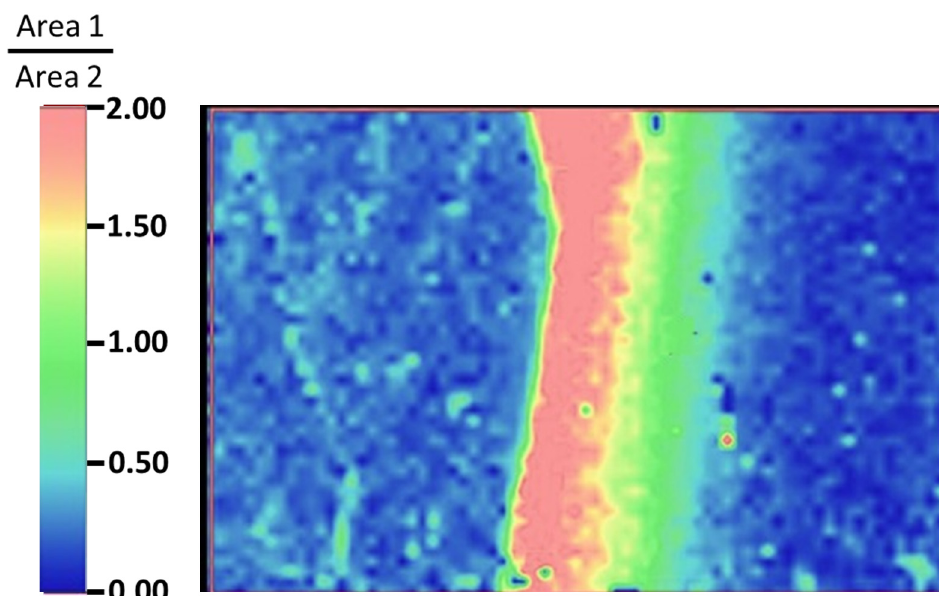
Figure 24. A low-resolution Raman map of the similar portion of the tourmaline sample shown in Figure 21. Pixel size is 50 µm and it took 48 min to generate this map.